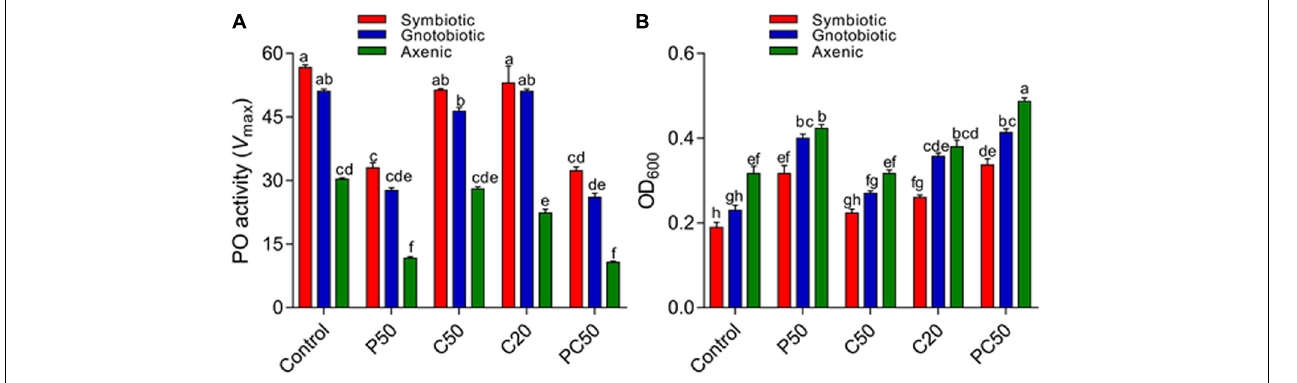
FIGURE 2 | Effect of diet and gut bacterial manipulation on the immune function of B. dorsalis larvae: PO activity (A) and antibacterial activity (B) .